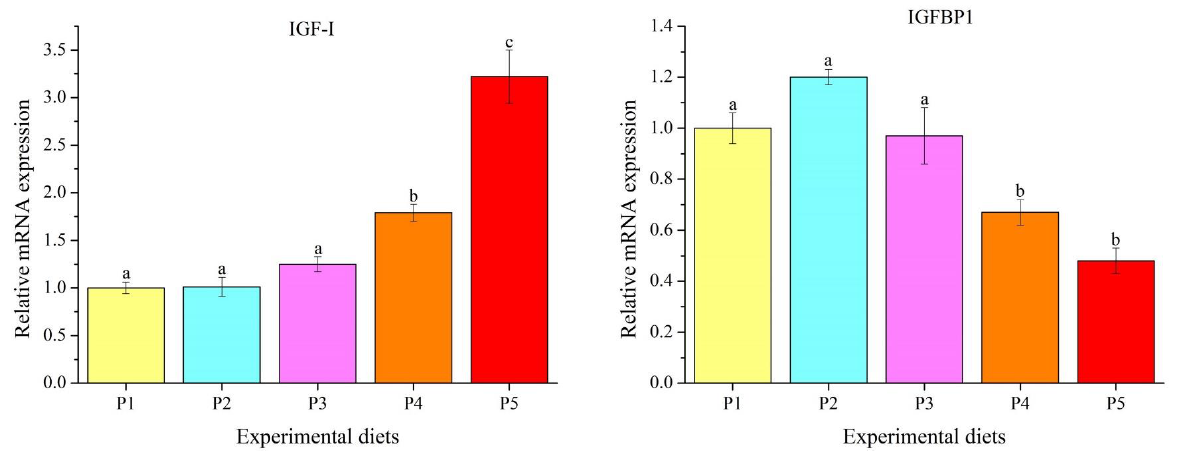
Figure 3. The mRNA levels of growth-related genes in the livers of Oncorhynchus mykiss fed experimental diets. Values are presented as mean ± SE, n = 4. Means with different superscripts are significantly different ( p < 0.05). IGF-I: ANOVA, 0.000; linear, 0.000; quadratic, 0.000. IGFBP1: ANOVA, 0.000; linear, 0.000; quadratic, 0.000.